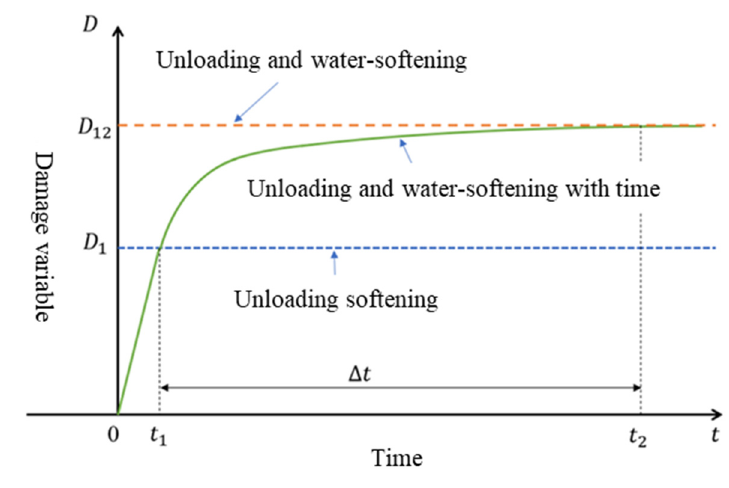
Figure 10. Time history curves of damage variables under different conditions.